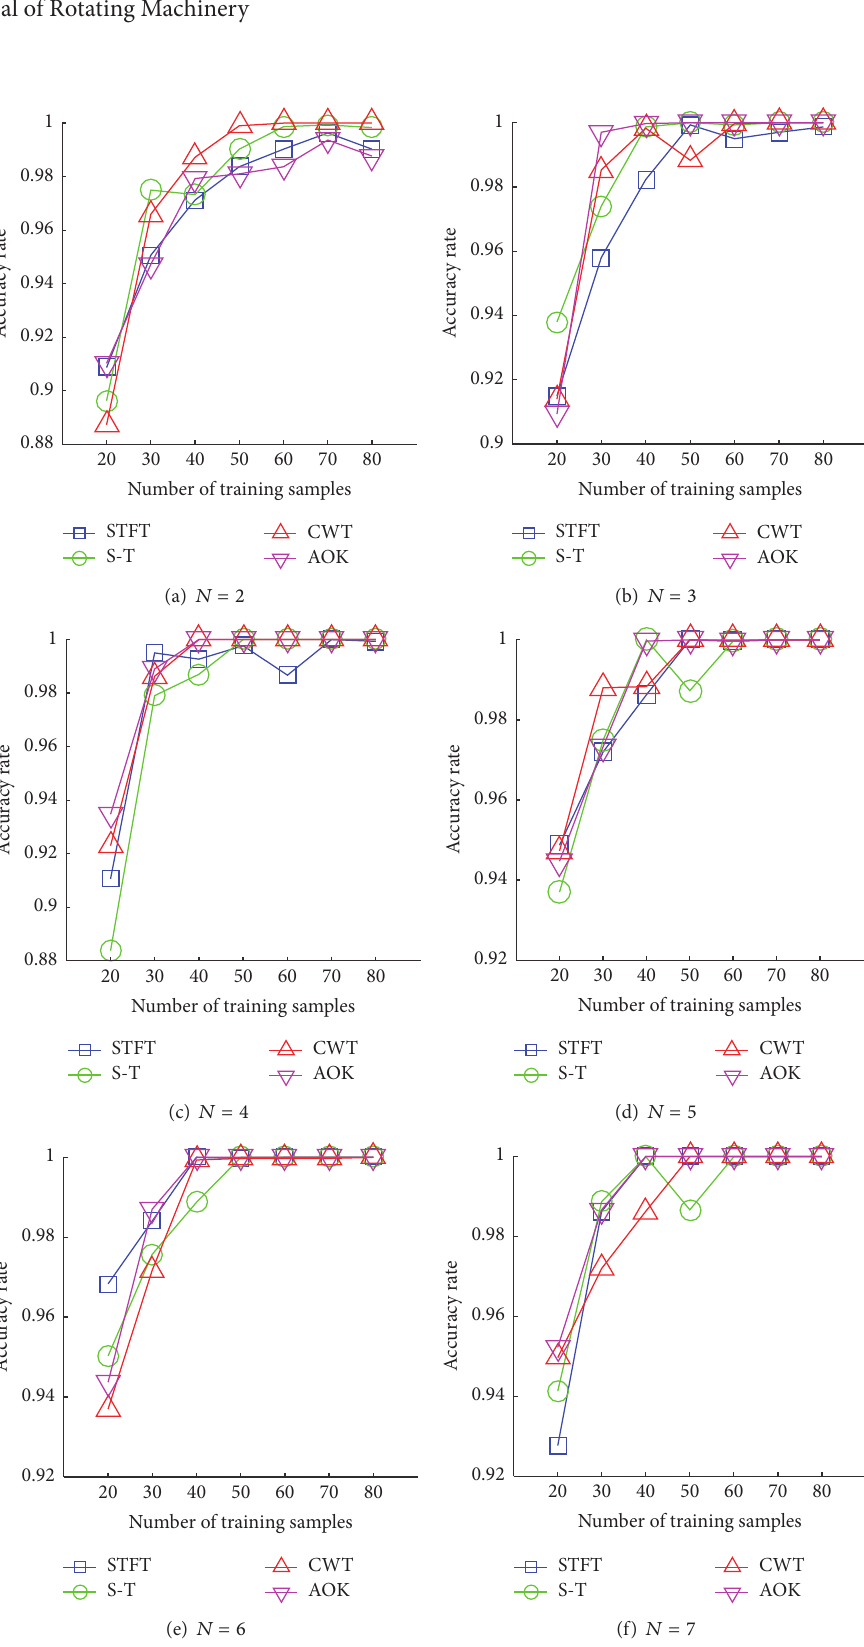
Figure 4: Recognition rate comparison between different time-frequency